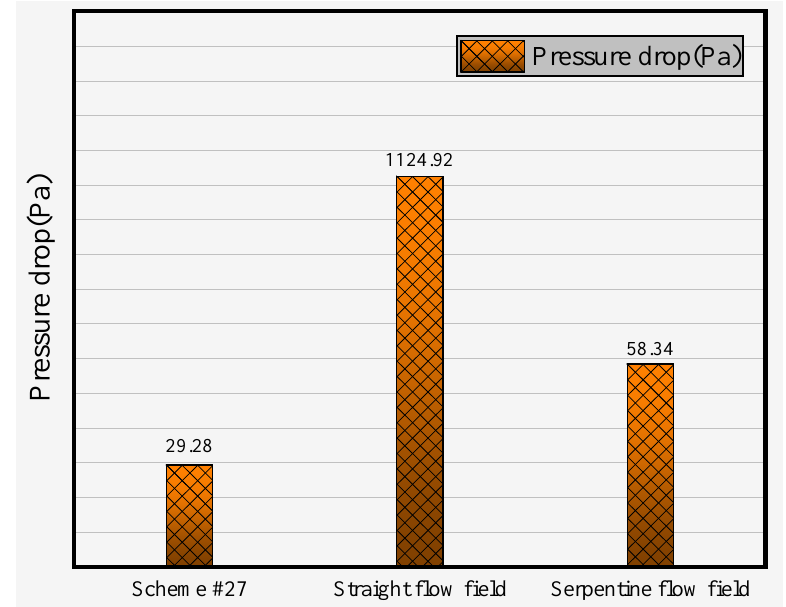
Figure 19. The pressure drop of scheme #27, straight flow field and serpentine flow field.